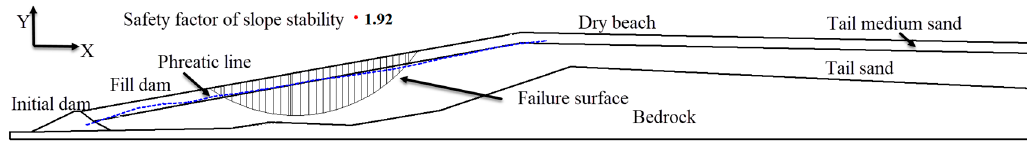
(c). Stability calculation with upstream slope ratio 1:200.